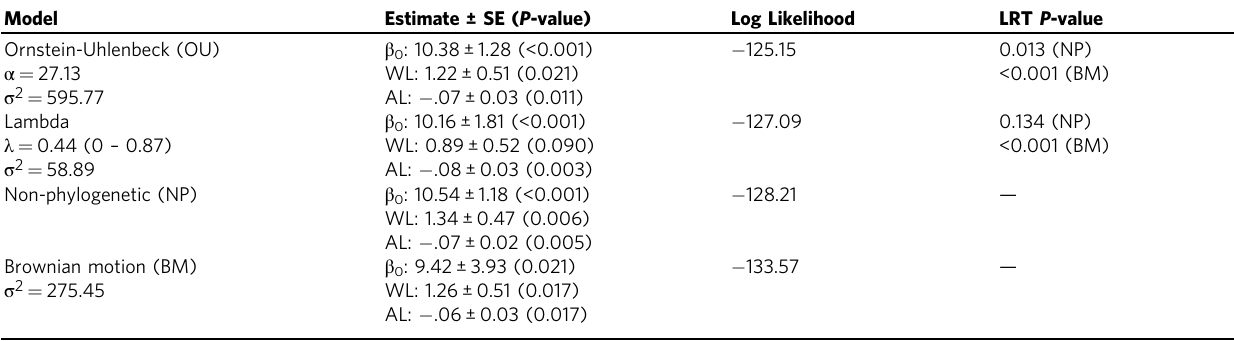
Table 1 The effect of wing loading and latitude on gull mantle darkness.